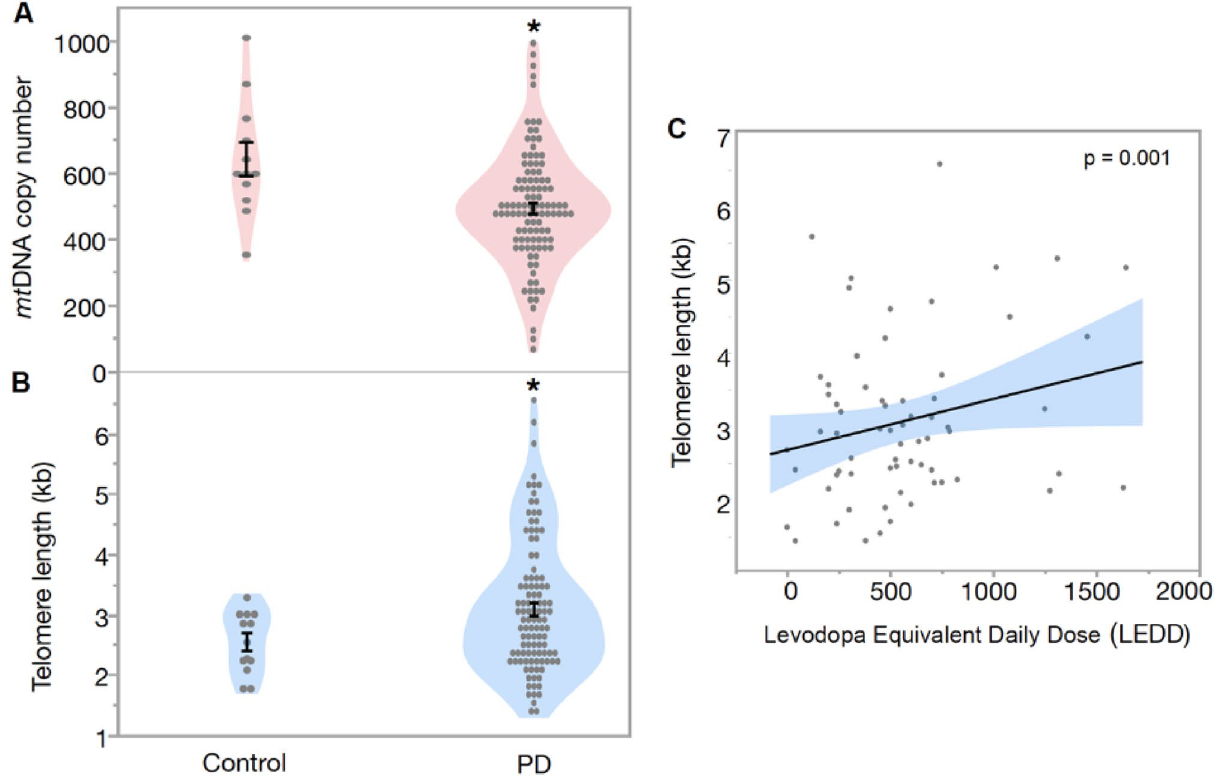
Figure 1. ( A ) Difference in mtDNA copy number and ( B ) telomere length between Parkinson’s Disease (PD) patients and controls in blood. Mean mtDNA copy number in PD patients was 505.99 ± 17.68, compared to controls 630.48 ± 52.88, while mean telomere length in PD patients was 3.21 ± 1.12 kb compared to the controls 2.54 ± 0.15 kb ( C ) Association between telomere length and Levodopa Equivalent Daily Dose (LEDD) in blood (multivariate regression). Data are presented as mean ± SE. * p < 0.05 versus